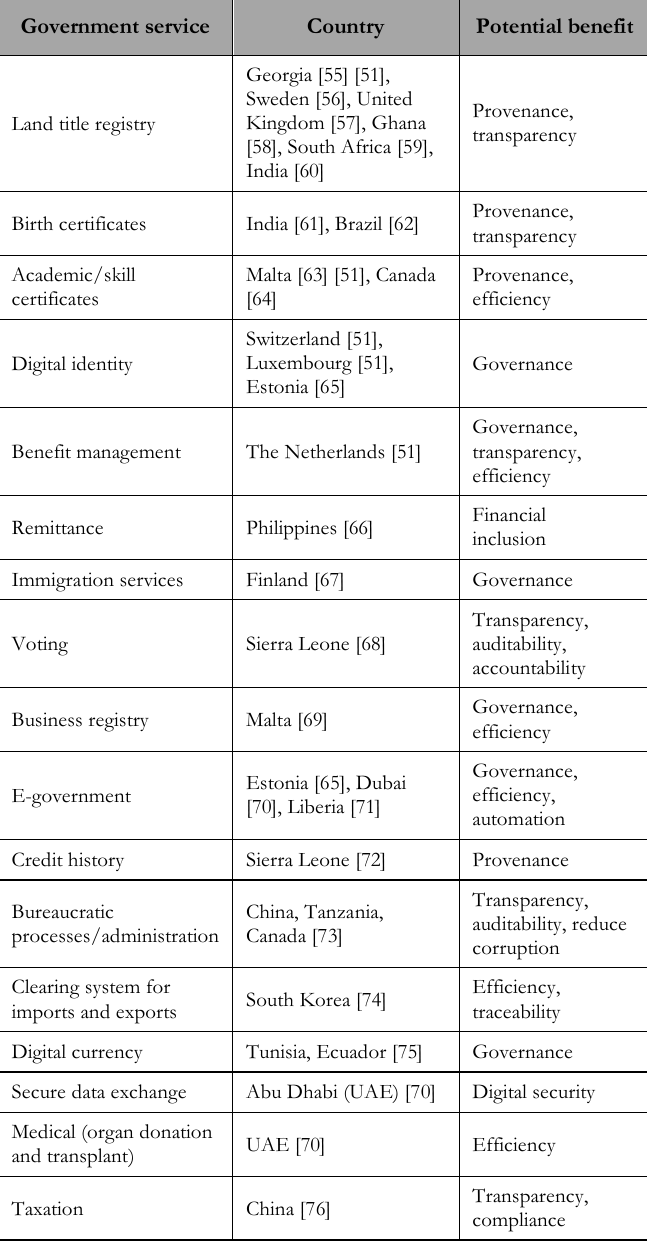
Table 1. Countries exploring BCT use cases worldwide with an aim of improving public services and trust with their